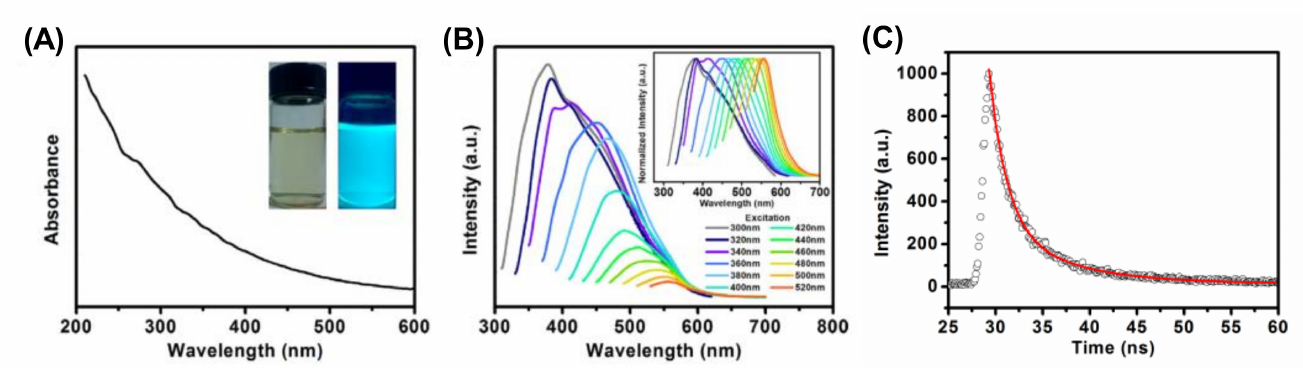
Figure 7. Characterization of S-CDs. ( A ) UV-Vis absorption spectrum. ( B ) PL spectrum at different λ ex. ( C ) Time-resolved PL. Reproduced from [169], with permission from Elsevier, 2014. a.u.: arbitrary